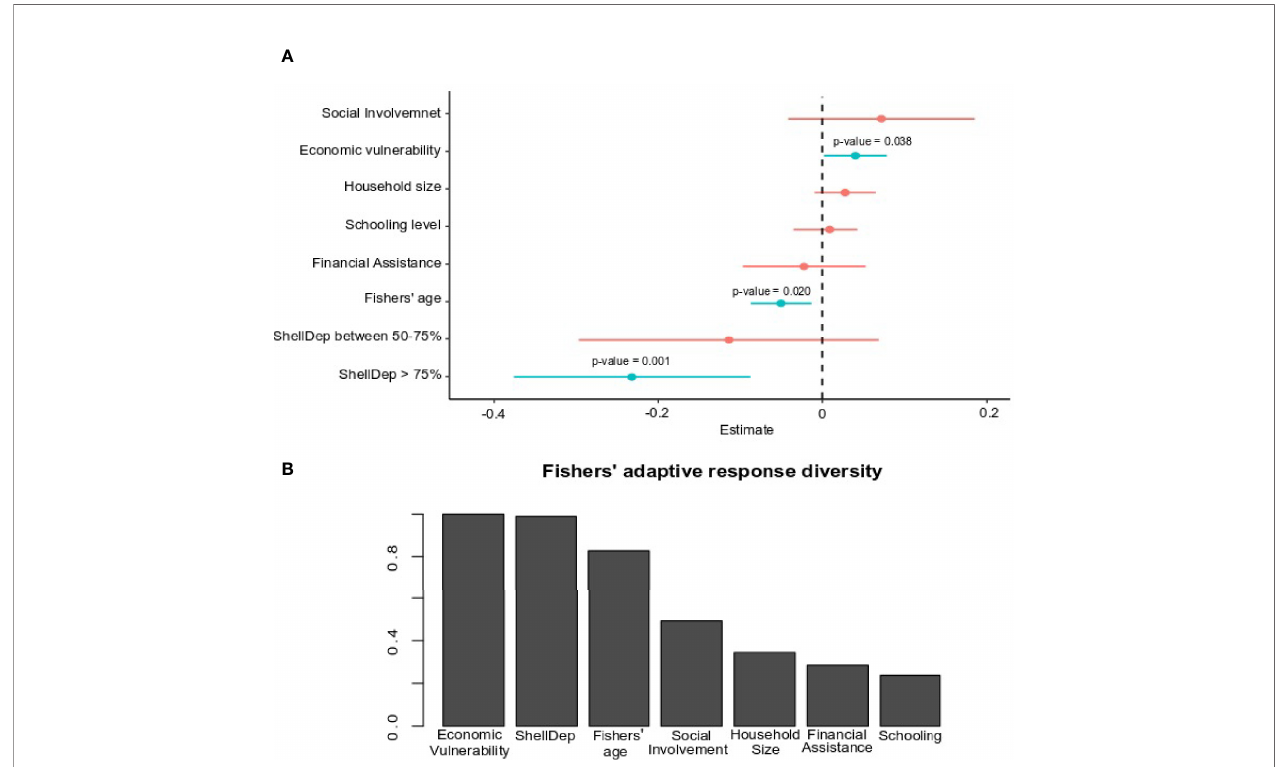
FIGURE 5 | (A) Coef fi cient estimates ( ± 95% CIs) showing the magnitude and direction of effects of predictors on the diversity of adaptive responses of fi shers, (B) bar chart showing variable importance scores for the effect of each predictor. The score varies from zero (less important) to one (more important). ShellDep between 50 - 75% denotes that dependency on income from shell fi sheries is between 50% and 75%, ShellDep >75% denotes that dependency on income from shell fi shing is higher than 75%. Signi fi cant variables are shown in blue. Non-signi fi cant variables are indicated in